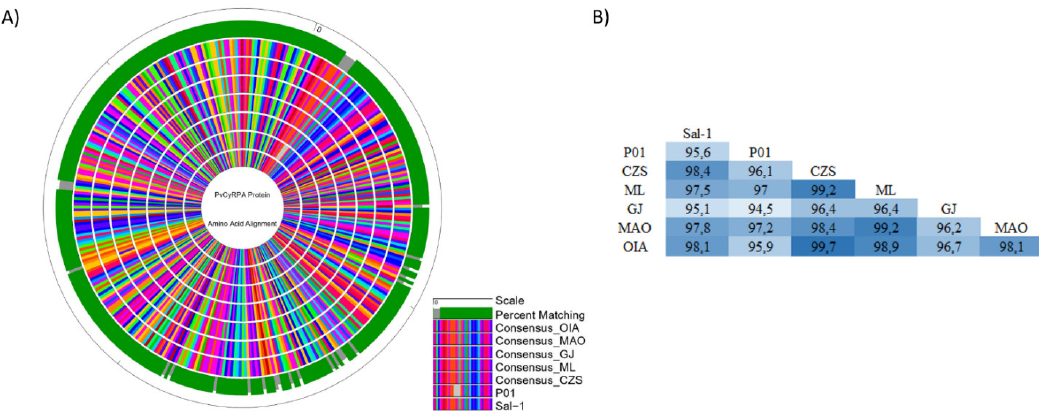
Figure 4. Homology analysis of PvCyRPA protein across isolates. ( A ) Circular alignment of amino acid sequences of PvCyRPA protein with reference sequence Sal-1 and P01 strain. The outer circle shows the amino acid scale. Green and gray bars on the second circle show the percent matching among all sequences used in the analysis. Inner circles show the sequence alignment in which each amino acid was represented by a different color. The legend presents the ordination to outer to inner rings: Scale; Percent Matching; Consensus OIA; Consensus MAO; Consensus GJ; Consensus ML; Consensus CZS; P01 strain; Sal-1 strain. ( B ) The pairwise distance among all sequences studied.